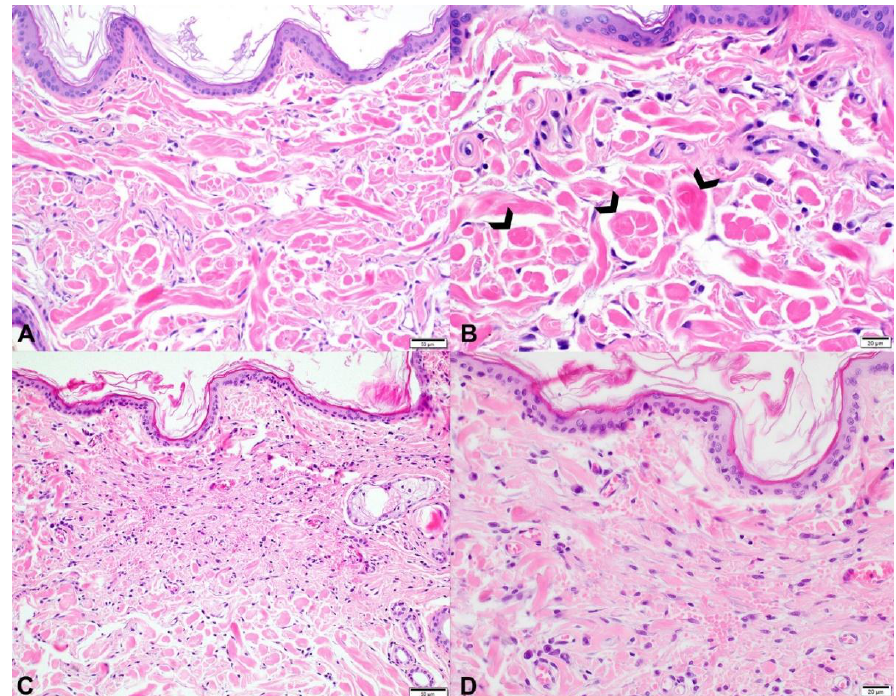
Figure 6. Comparison of histopathology findings in the skin of two dogs with Ehlers–Danlos syndromes (EDS)-like syndrome attributed to different mutations in the COL5A1 gene. ( A,B ): Photomicrographs of skin from the dorsum of the dog (case 1) with EDS-like syndrome attributed to a single nucleotide deletion and premature stop codon formation in the COL5A1 gene. Throughout the dermis, there is collagen fiber disorganization with great variation in fiber diameter, length, and staining intensity. 200 × original magnification; bar = 50 microns. ( B ): Collagen fibers frequently form variably sized, hypereosinophilic clumps (open arrowheads). 200 × original magnification; bar = 50 microns. ( C,D ): Photomicrographs of skin from one of the affected siblings with EDS-like syndrome attributed to a missense variant in the COL5A1 gene. ( C ): Underneath the unremarkable epidermis, abnormal collagen fibers are present in the superficial and mid dermis. Collagen fibers are very short, thin, wispy, and disorganized. Some broader, hypereosinophilic fibers are present. 200 × original magnification; bar = 50 microns. ( D ): In the upper dermis, horizontally aligned fibroblasts are present, indicating reparation of previous ruptures. In between the altered collagen fibers, there are numerous extravascular erythrocytes compatible with excessive hemorrhage. Compared to case 1 (panels A,B), large dermal collagen clumps are not present. 400 × original magnification; bar = 20